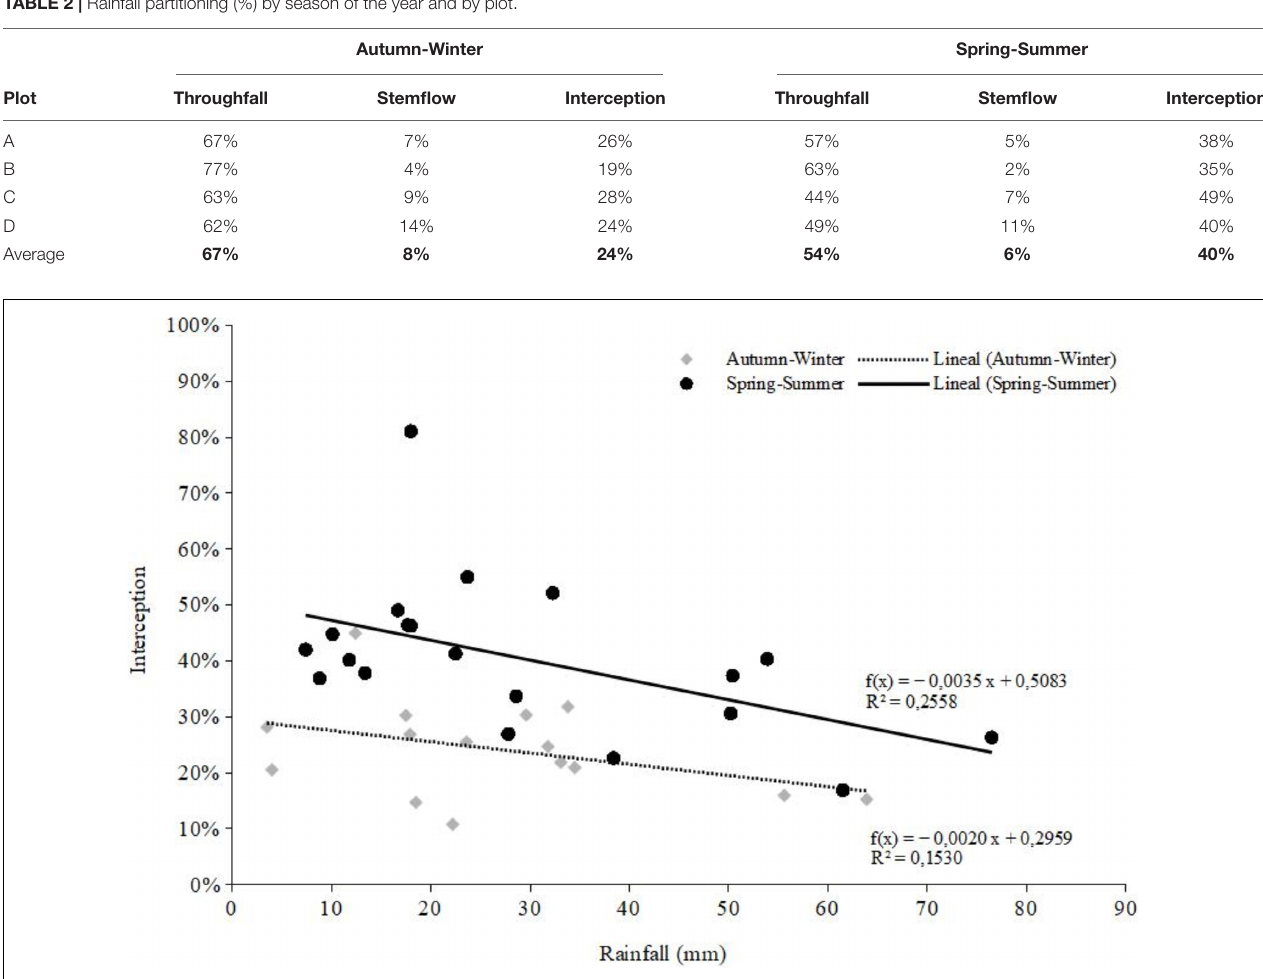
FIGURE 2 | Seasonal interception percentage of secondary forest and its relationship with rainfall magnitude.